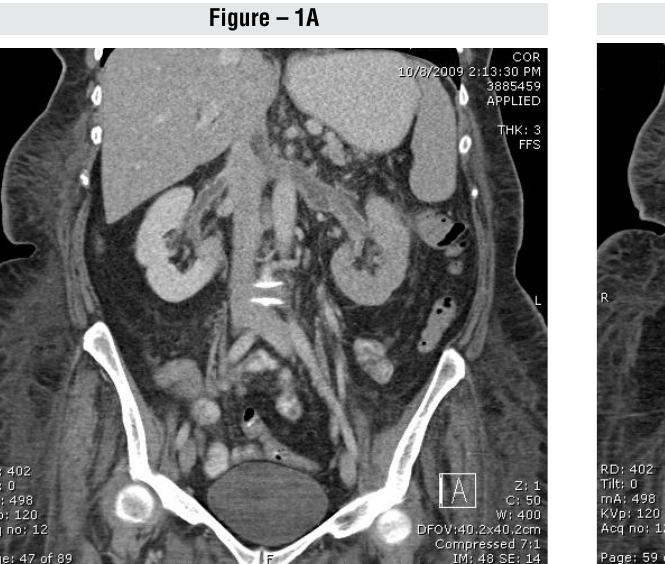
Figure 1 - Initial CT scan showing perfusion changes consistent with bilateral renal vein thrombosis and a heterogeneously enhancing solid mass with cystic components of left